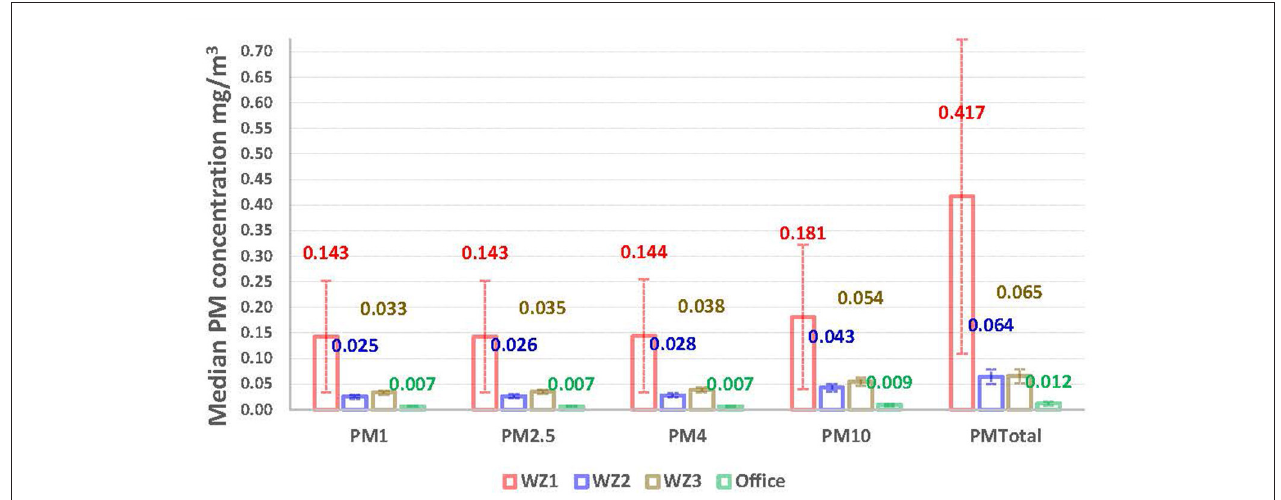
FIGURE 1 | Exposure levels (median with interquartile range) of ambient particulate matter